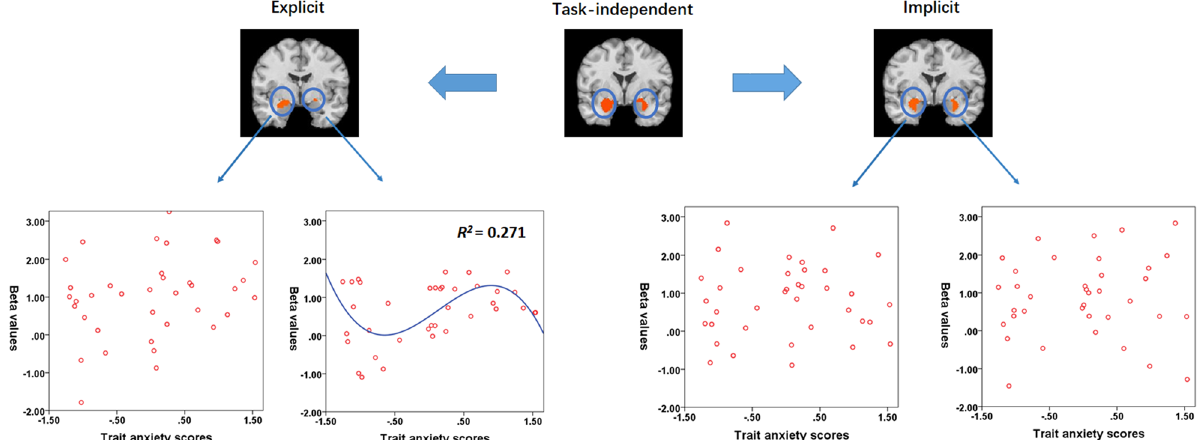
Figure 3. The upper panel: the task-dependent and independent effects of pictorial emotion on amygdalar responses. The lower panel: the relation between trait anxiety and amygdalar responses to threat vs. neutral pictures. A cubic model was the best fit for the right amygdala in the explicit condition. There were no significant models for the left amygdala or the implicit condition. Results only showed an association between trait anxiety and right amygdalar responses in the explicit